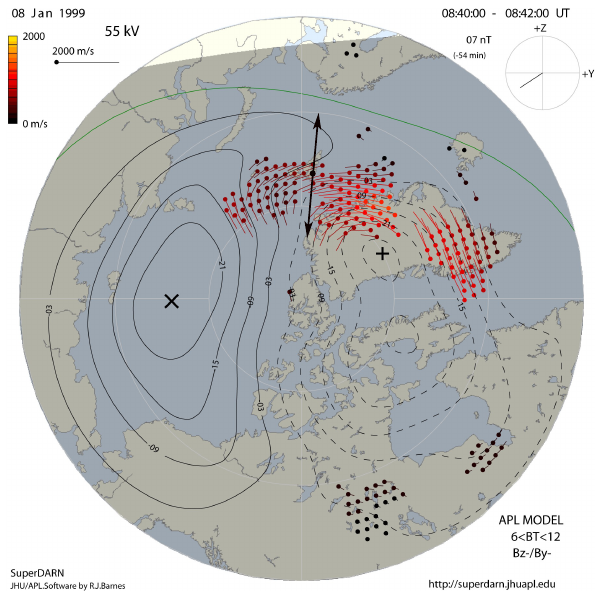
Fig. 18. SuperDARN convection data for 08:40–08:42UT. Same format as in Fig. 8.